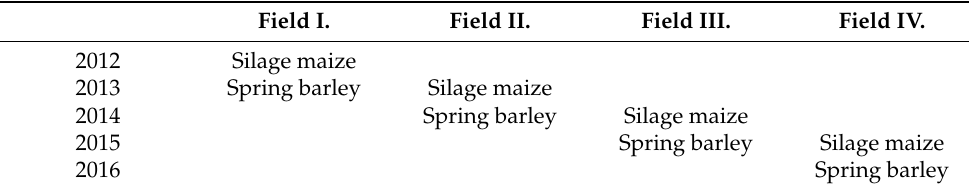
Table 2. The scheme of the trial in the period